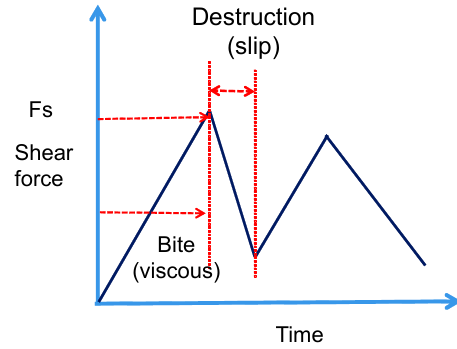
Figure 6. Curve of shear force variation with time in the process of the biting-destruction-batching of the microconvex body.